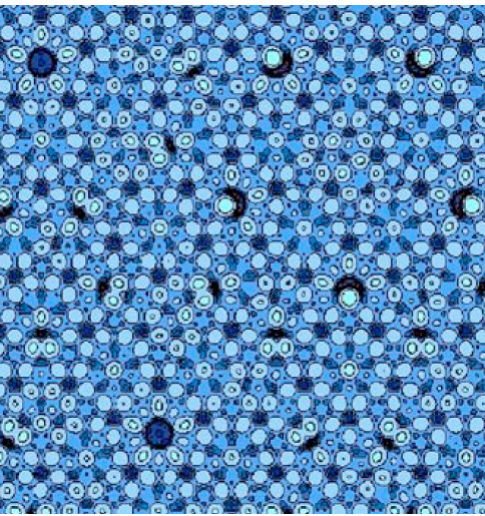
Figure 1 . An example of quasicrystal, which is a crystal with ordered but aperiodic structure, lacking in particular translational invariance. Picture adapted from